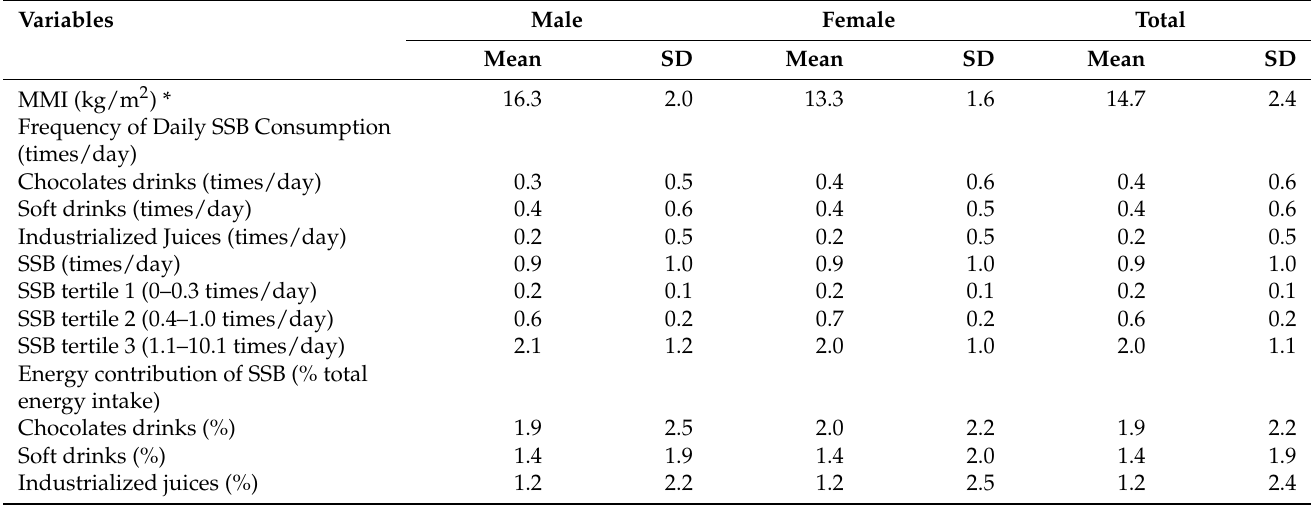
Table 2. Consumption of sugar-sweetened beverages, macronutrients, and sugar in beverages and muscle mass index in adolescents according to sex. Sao Luis, Brazil,